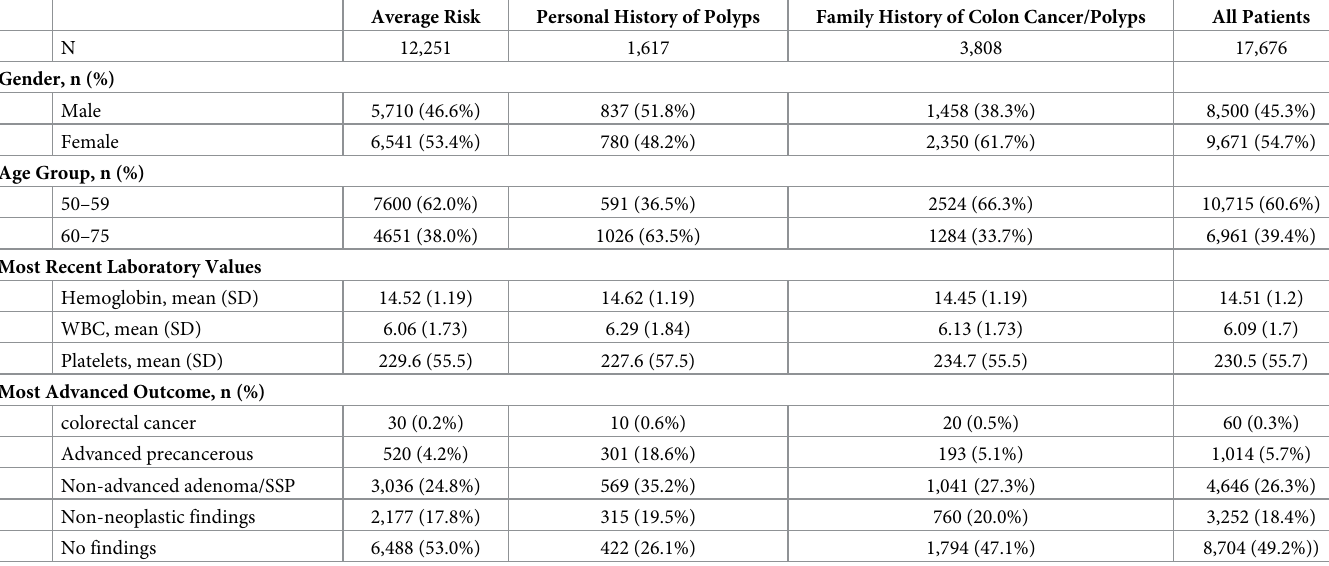
Table 1. Study sample: Baseline characteristics and colonoscopy